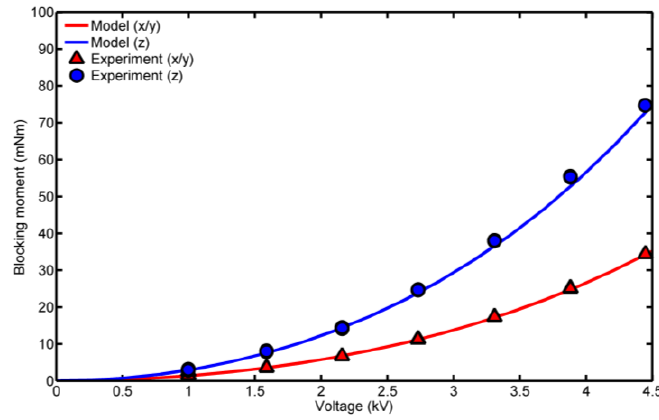
Figure 7. Blocking moment generated about each axis against